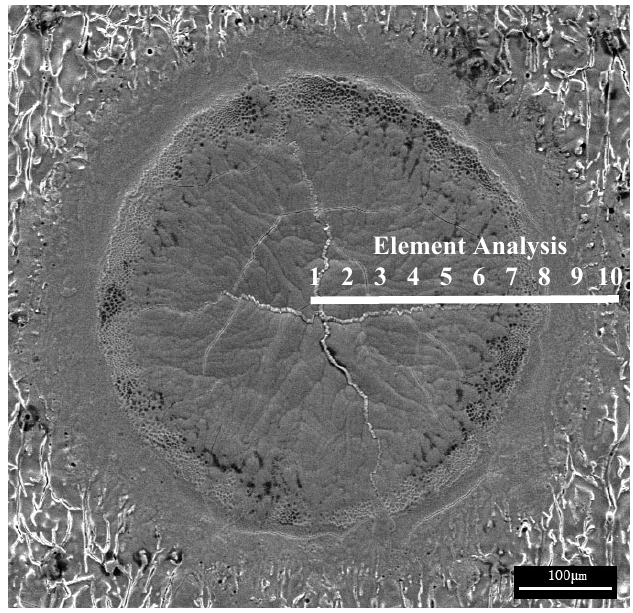
Figure 12. Surface morphology of laser radiation zone.